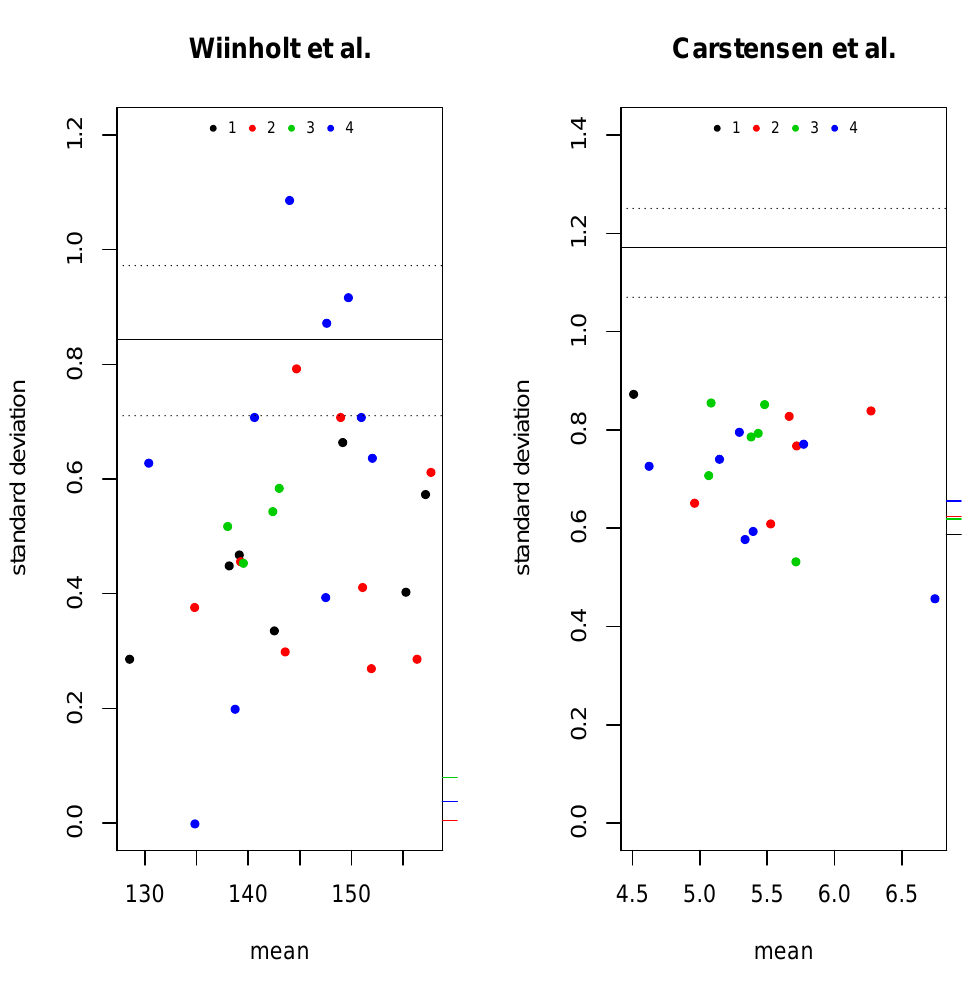
Figure 5. Extended BA plot on real-world data. Wiinholt et al. [21] ( left ) and Carstensen et al. [22] ( right